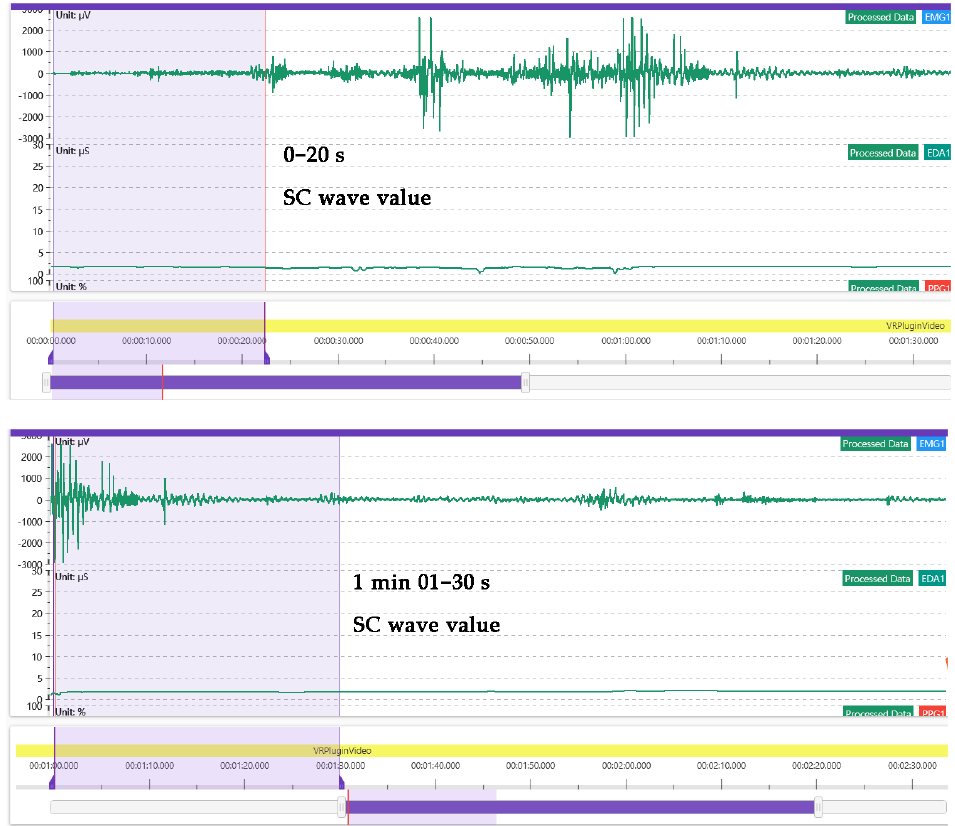
Figure 6. SC fluctuation value extraction. Source: ErgoLAB Platform Screenshot. The emotional arousal state during 0 − 20 s and 1 − 30 s of 1 min was intercepted to calculate the SC range of the arousal state during 0–20 s and 1–30 s of 1 min was intercepted to calculate the SC range of the subjects.